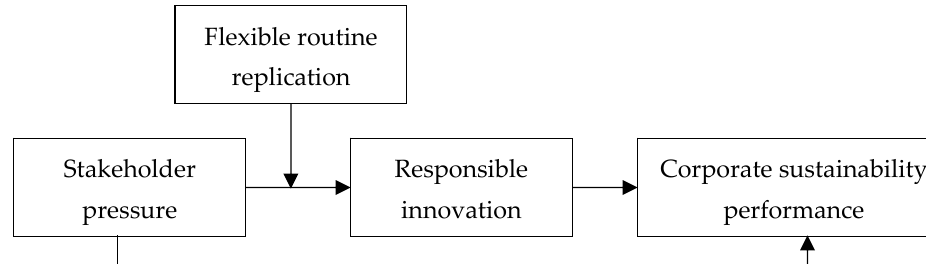
Figure 1. Theoretical model.